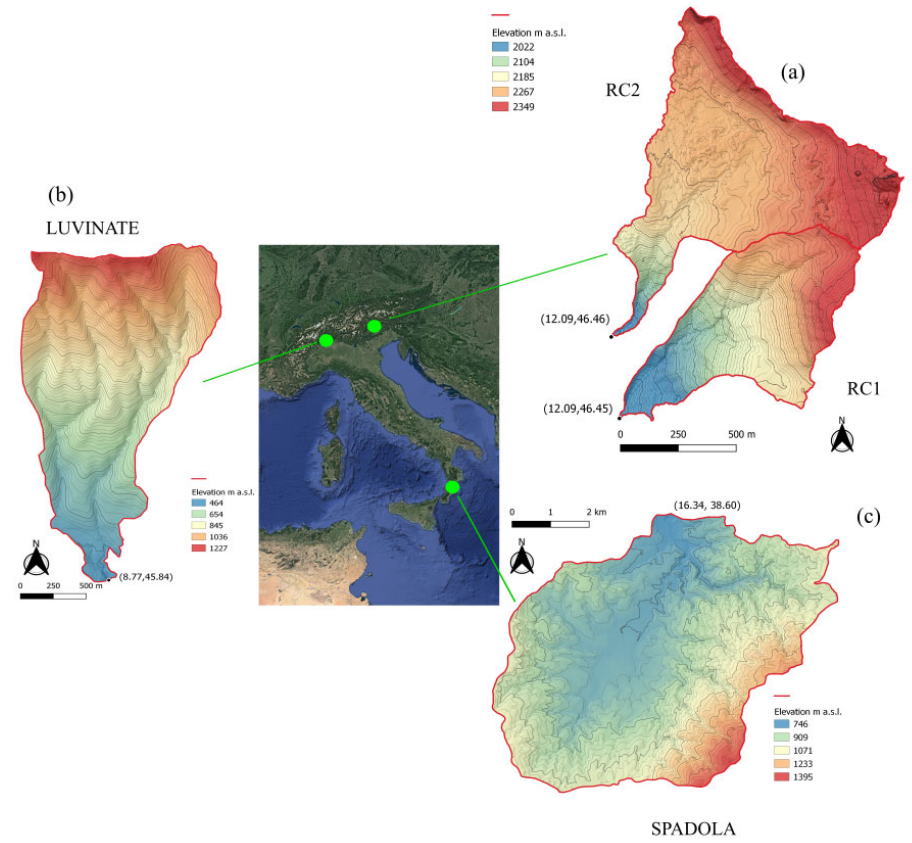
Figure 3. Catchments considered in this work and geographical coordinates (WGS84) of the outlet sections. A 1 m resolution DEM is available for RC1 and RC2 basins ( a ) whereas a 5 m resolution DEM is available for Luvinate ( b ) and Spadola ( c ).